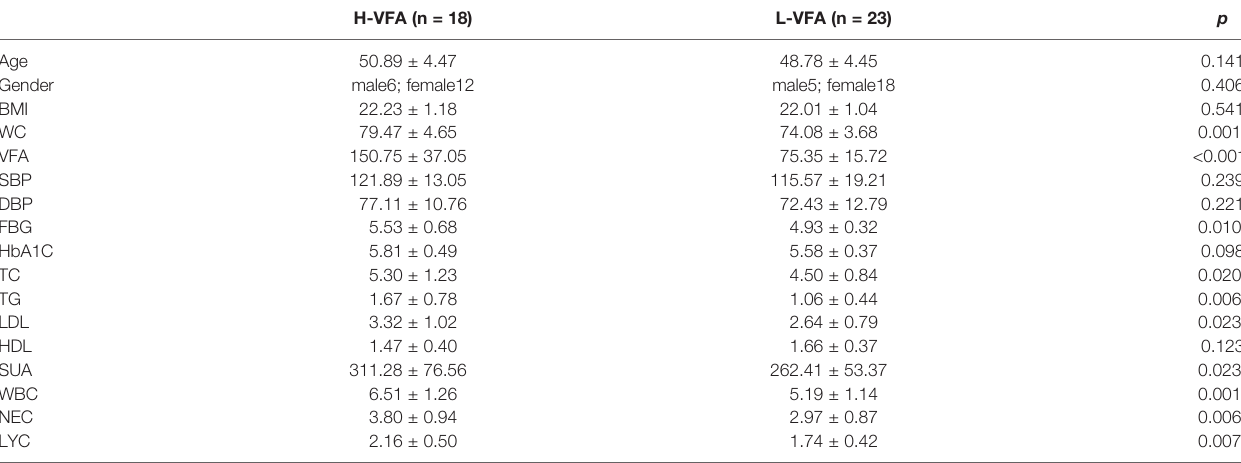
TABLE 1 | The essential characteristics and laboratory test